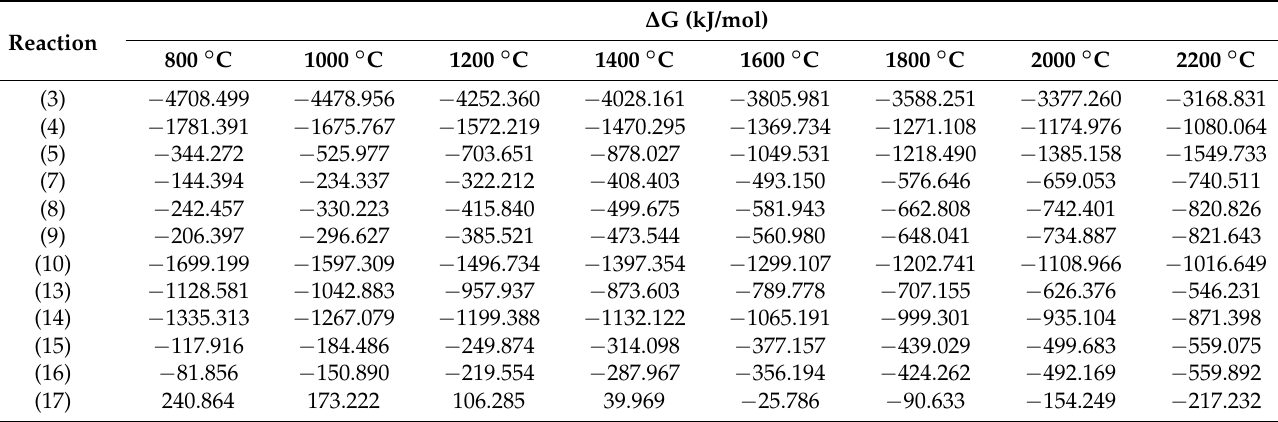
Table A1. Thermodynamic parameters 2 of